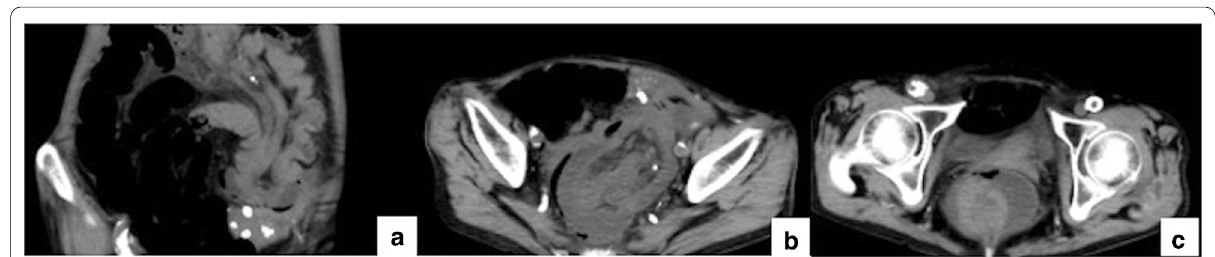
Fig. 2 Abdominal computed tomography (CT) images. a Sausage-shaped sign in the descending colon. b Enlargement of the colorectal wall, fat within the intussusception, and air within the intussuscipiens in the pelvis. c Mass in the